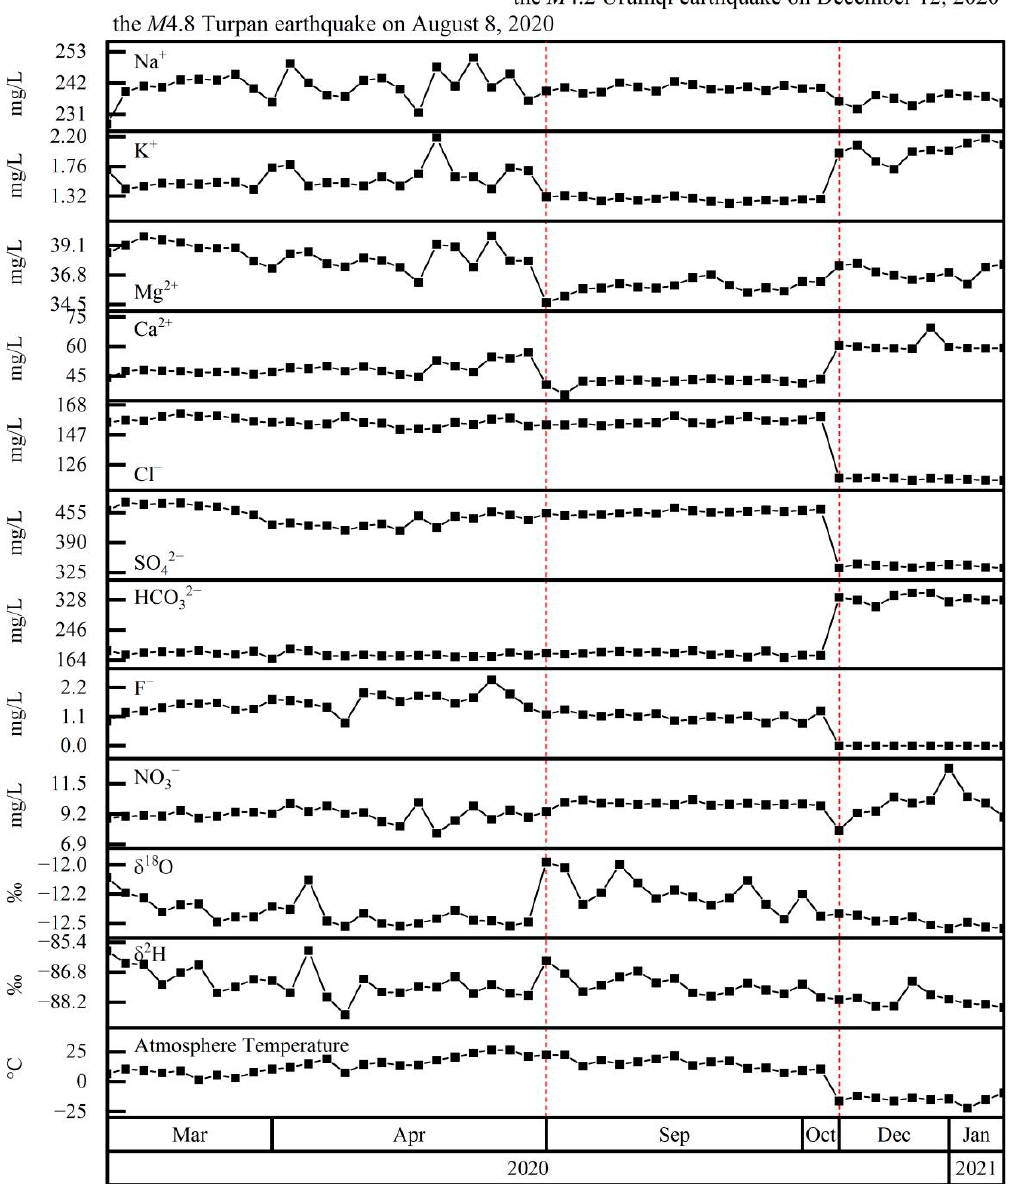
Figure 4. Time series of Spring 09 major ion concentrations (Na + , K + , Mg 2+ , Ca 2+ , Cl − , SO 42 − , HCO 3 − , F − , and NO 3 − ), stable isotopes ( δ 2 H, δ 18 O), and atmospheric temperature. Red-dashed lines mark the occurrence of potentially significant earthquakes within the study area.